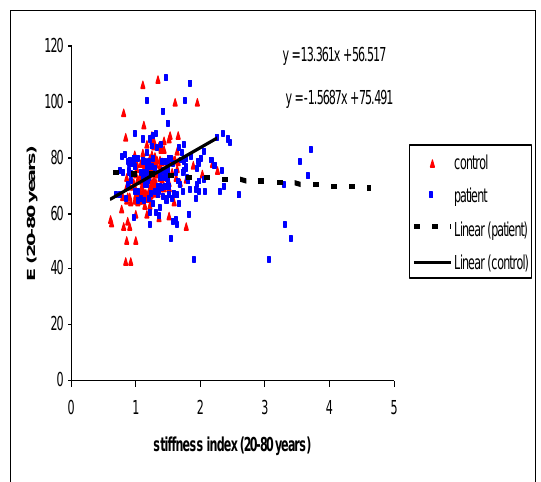
Fig.1: The relation between stiffness index and peak early (E) diastolic filling velocities.